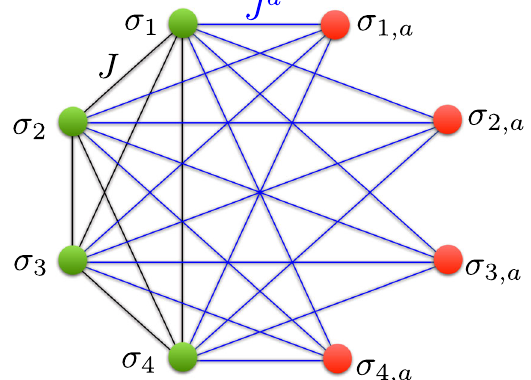
Fig. 1 Graph showing the connectivity of the Hamiltonian Eq. (3) for N = 4. The green vertices represent the logical qubits while the red vertices represent the ancillas. The logical qubits are fully connected amongst themselves with two-body couplings, represented as edges, of strength J ( black ). Each ancilla is connected to every logical qubit with two-body couplings of strength J a ( blue